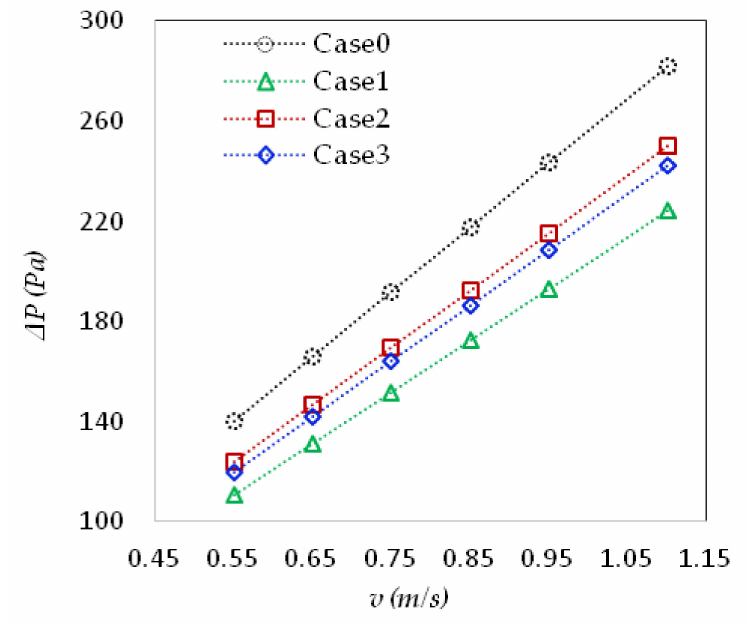
Figure 5. Pressure drops of the four cases at different inlet velocities.